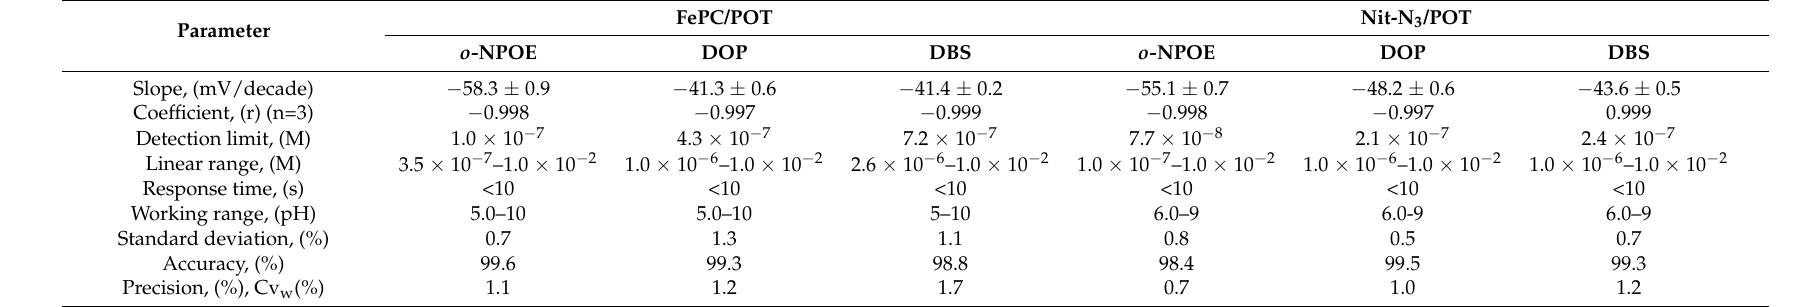
Table 1. Response characteristics of azide membrane sensors in 0.01 M Tris buffer of pH 7.